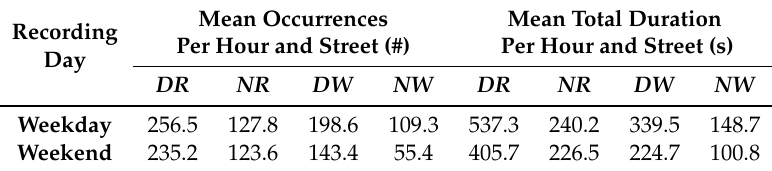
Table 5. Mean number of occurrences and total duration per hour obtained for the weekday and weekend day, distinguishing between day- and night-time periods, being the diurnal period defined as 06:00–22:00 [29], and averaging the features by the number of sensed hours per period and number of streets per type. Mean Occurrences Mean Total Recording Per Hour and Street (#) Day